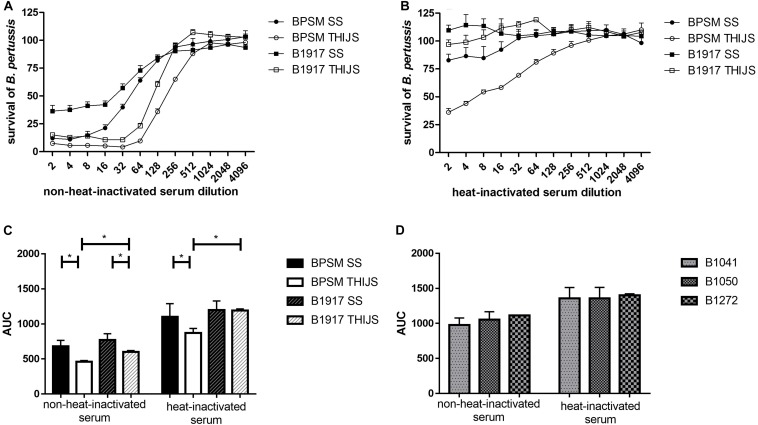
Dose-dependent B. pertussis growth inhibition by non-heat-inactivated and heat-inactivated human anti-pertussis serum. BPSM (circles) and B1917 (squares), grown in SS (black) or THIJS (white) medium were incubated for 4 h with two-fold serial dilutions, ranging from 1/2 to 1/4096, with (A) NIBSC (06/140) serum or (B) heat-inactivated NIBSC (06/140) serum. The luminescence reads were normalized to bacteria grown without antiserum. (C) AUC were calculated using the data depicted in Figures 5A,B for BPSM grown in SS medium (black bars) or in THIJS medium (white bars) and B1917 grown in SS medium (gray hatched black filled bars) or THIJS medium (gray hatched white filled bars). (D) Calculated AUC of dose-dependent pertactin-deficient B1041 (white bars), B1050 (gray bars) and B1272 (black bars) growth inhibition by non-heat-inactivated and heat-inactivated human NIBSC (06/140) serum, as indicated, after 4 h incubation with two-fold serial dilutions, ranging from 1/2 to 1/4096. Statistical analyses were performed with a two-tailed, Student’s t-test on three independent experiments. *p < 0.05, **p < 0.005.